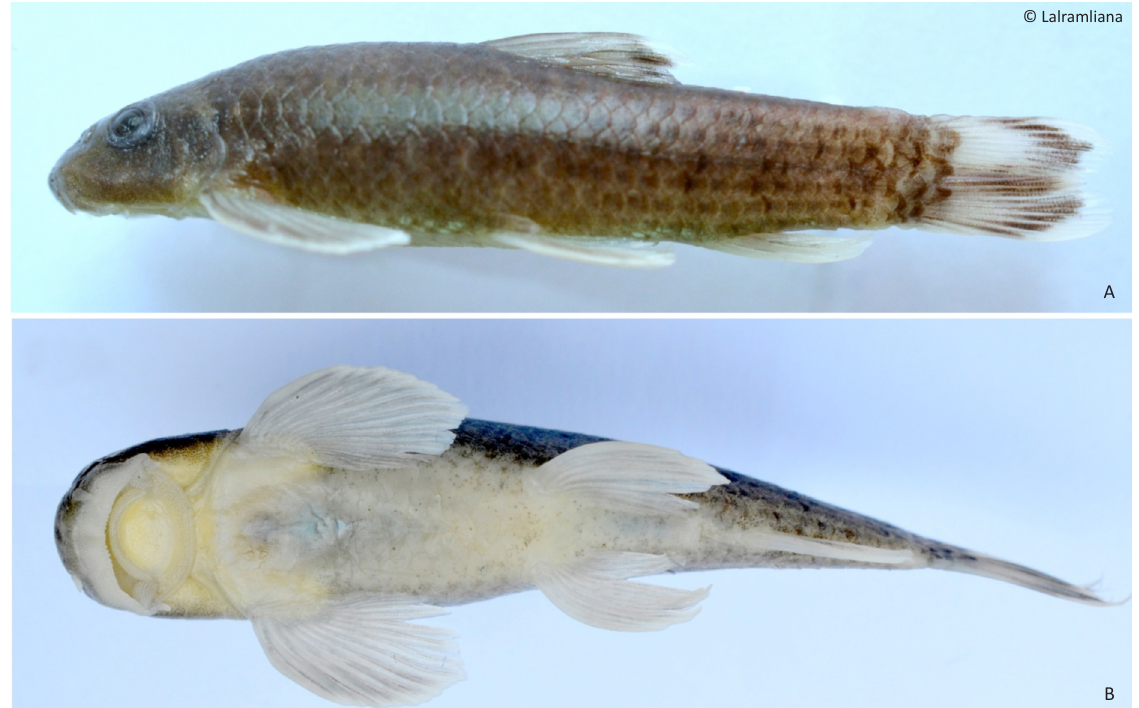
margin modified to form a transverse skin fold covered by numerous tiny papillae, anteriorly separated from lower jaw by a deep groove running along lower jaw and posteriorly bordered in a deep groove with a central pad. Central pad wider than long, lateral and posterior